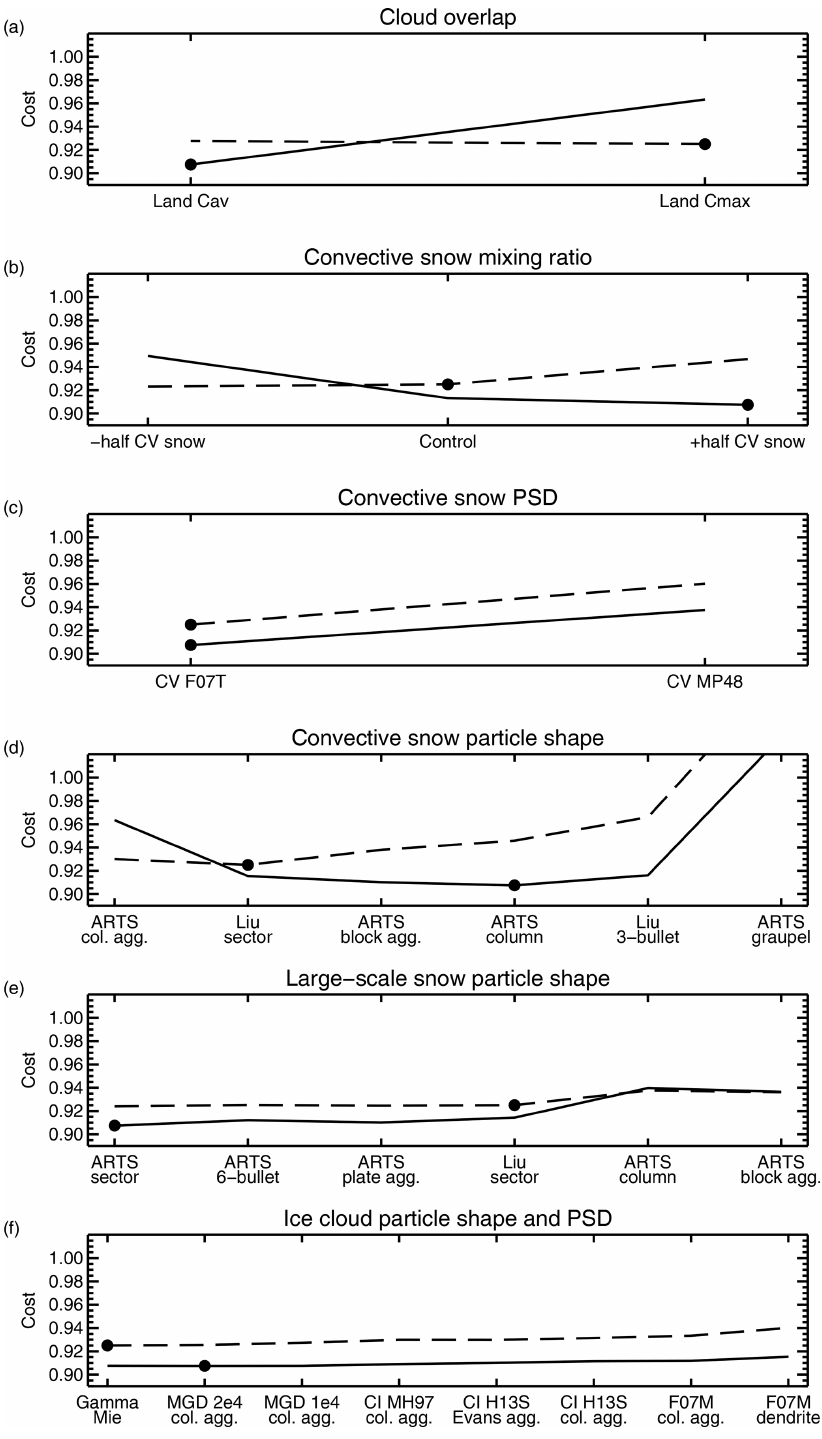
Figure 5. Slices through the six-dimensional cost function around the control configuration (dashed) and around the best configuration (solid; see also Table 4). The dimensions are ordered from least-scattering to most-scattering options. The dots indicate the parameter settings for the control and for the very best (lowest cost)